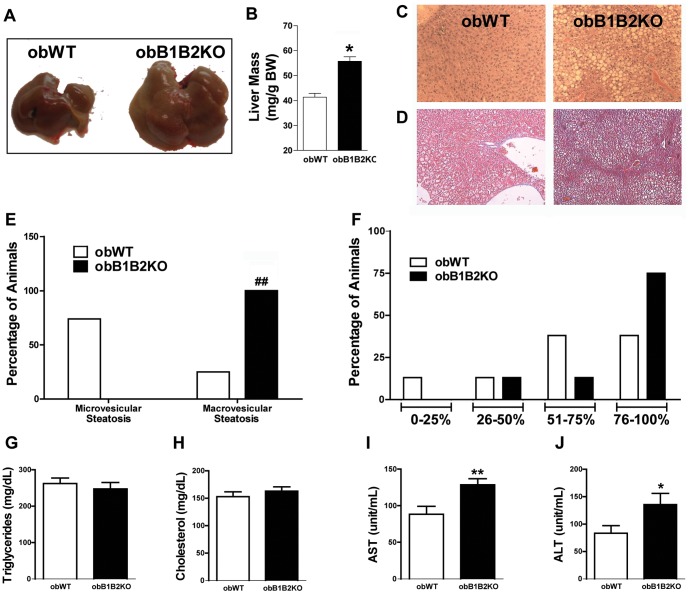
KKS protects the liver against steatosis in obese mice.A) Representative picture of the sizes of livers from 6-month-old mice; B) Averages of liver relative mass from 6-month-old mice; C) Representative picture comparing hematoxylin and eosin stained liver sections; D) Representative picture comparing Masson’s trichrome protocol; E) Percentage of the predominant type of non-alcoholic hepatic steatosis from histological analysis; F) Percentage of non-alcoholic hepatic steatosis levels from histological liver analysis; G and H) Serum lipid profile; I and J) Hepatic function analysis demonstrated by plasma transaminases measurements, aspartate aminotransferase (AST) and alanine aminotransferase (ALT). The data are presented as the means ± SEM. t student: *, p<0.05; **, p<0.01; Analysis of Contingency Table: # #, p<0.01; n = 8.